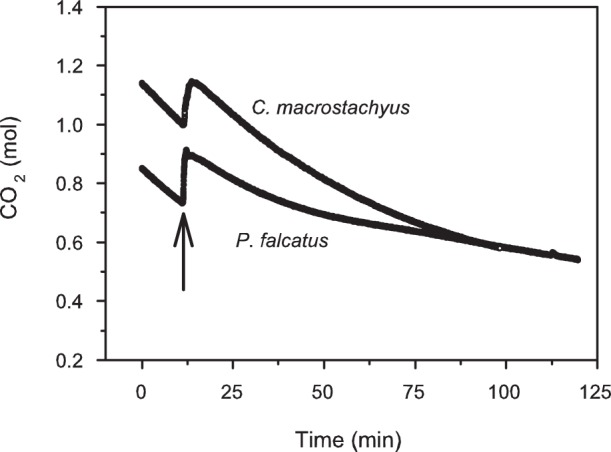
Change in the apparent amount of CO2 (mol) in chambers of Croton macrostachyus and Podocarpus falcatus during the 13CO2-labeling period.The decline in the amount of CO2 reflects the predomination of photosynthesis over leaf and stem respiration. The arrow shows the release of 12.3 mmol 13CO2 m−3 chamber volume.